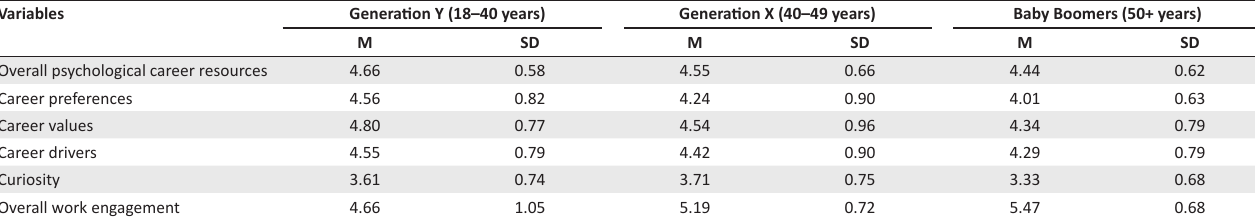
TABLE 4: Means and standard deviations of significant pairwise comparisons.